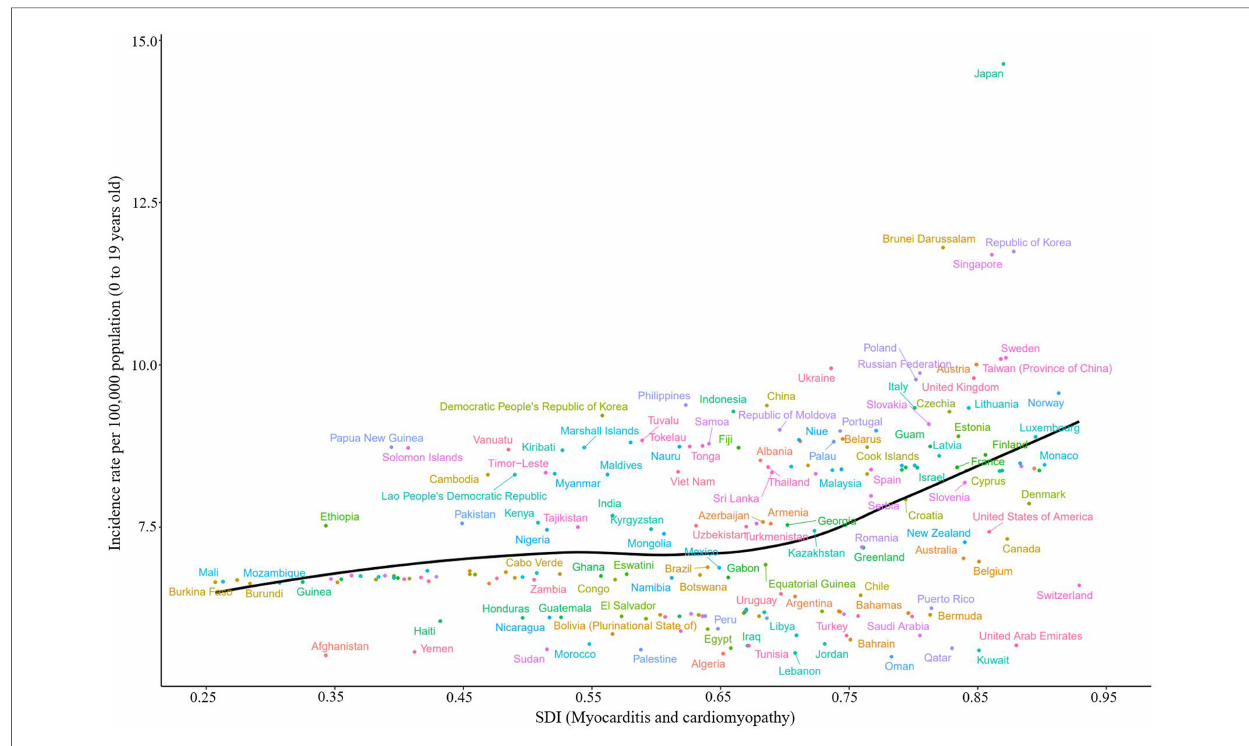
FIGURE 3 Age-standardized incidence due to childhood myocarditis and cardiomyopathy by country and SDI, 2019; the black line represents expected values. Globally, the age-standardized incidence of childhood myocarditis and cardiomyopathy increased with SDI in 2019. SDI, sociodemographic